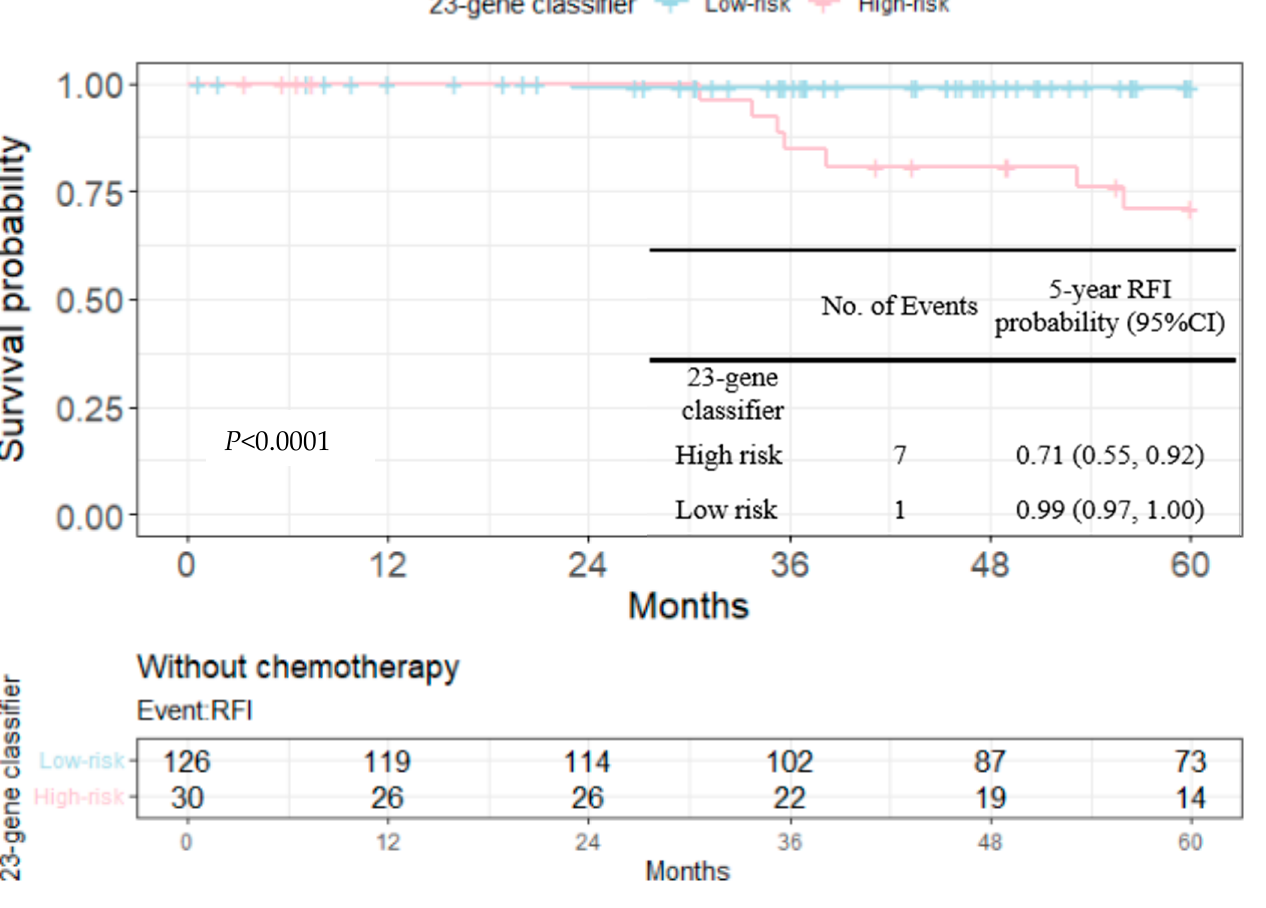
Figure 8. Kaplan–Meier plot for the RFI among patients without chemotherapy within 5 years to compare the partition of 23-gene classifier. Blue: genetic low-risk group; red: genetic high-risk group.